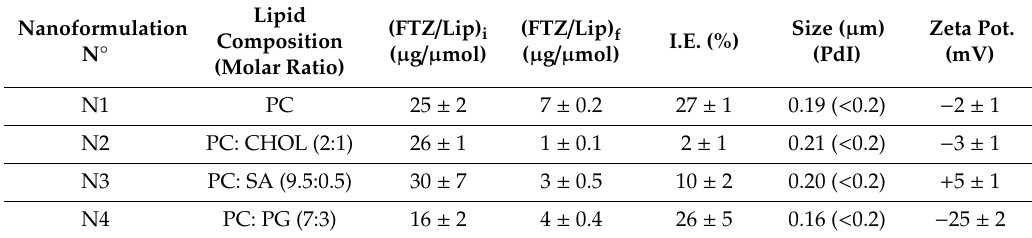
Table 2. Physicochemical Properties of FTZ Liposomes.